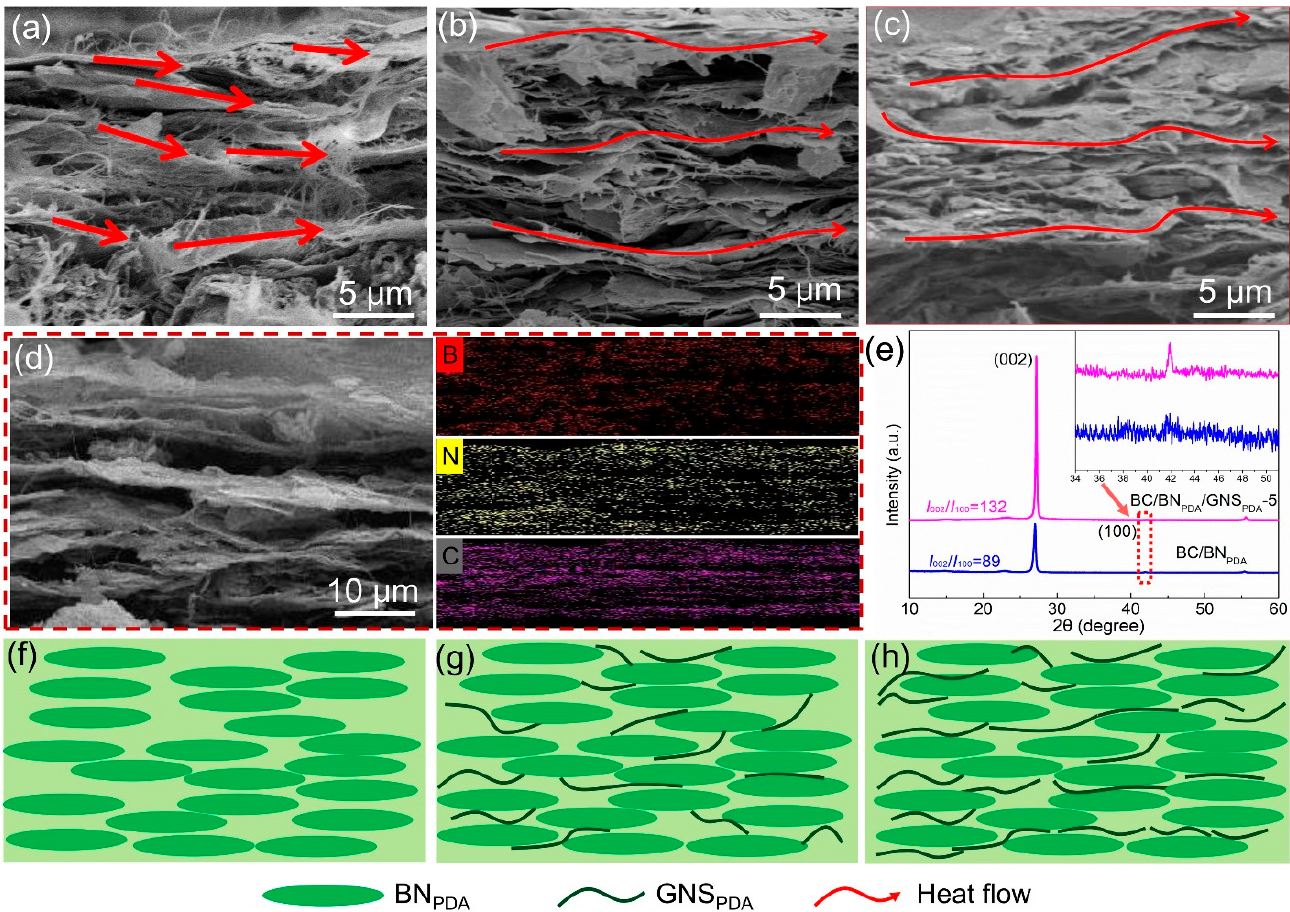
Figure 2. ( a – c ) SEM images of cross section of three composite films: BC/BN PDA , BC/BN PDA /GNS PDA -5, and BC/BN PDA /GNS PDA -10. ( d ) Elemental mapping images of B, N, and C in the BC/BN PDA /GNS PDA -5 composite film. ( e ) XRD patterns of BC/BN PDA and BC/BN PDA /GNS PDA -5 composite films. ( f – h ) Schematic diagrams of the distributions of hybrid fi llers.